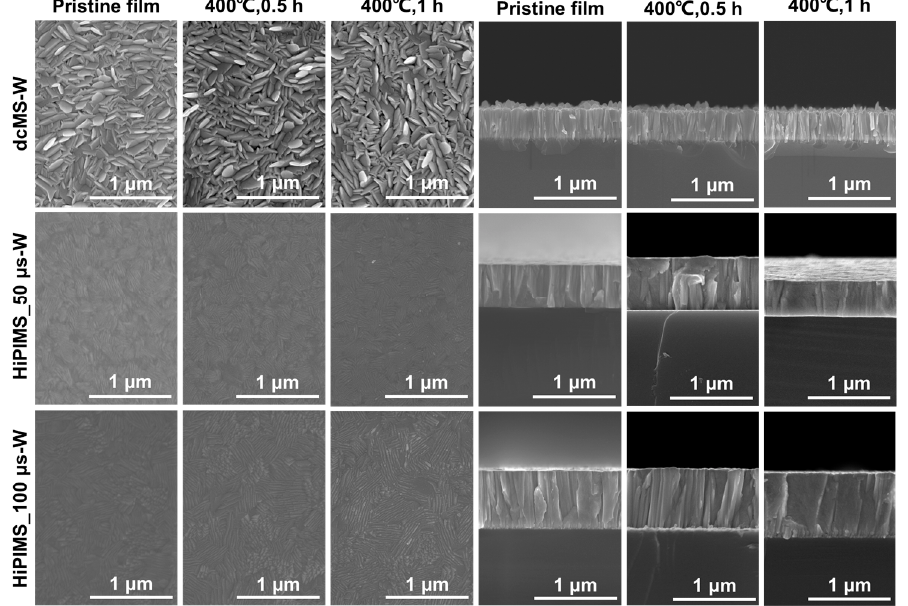
Figure 9. Surface and cross-sectional SEM images of W thin films after vacuum annealing at 400 °C for 0.5 and 1 h.